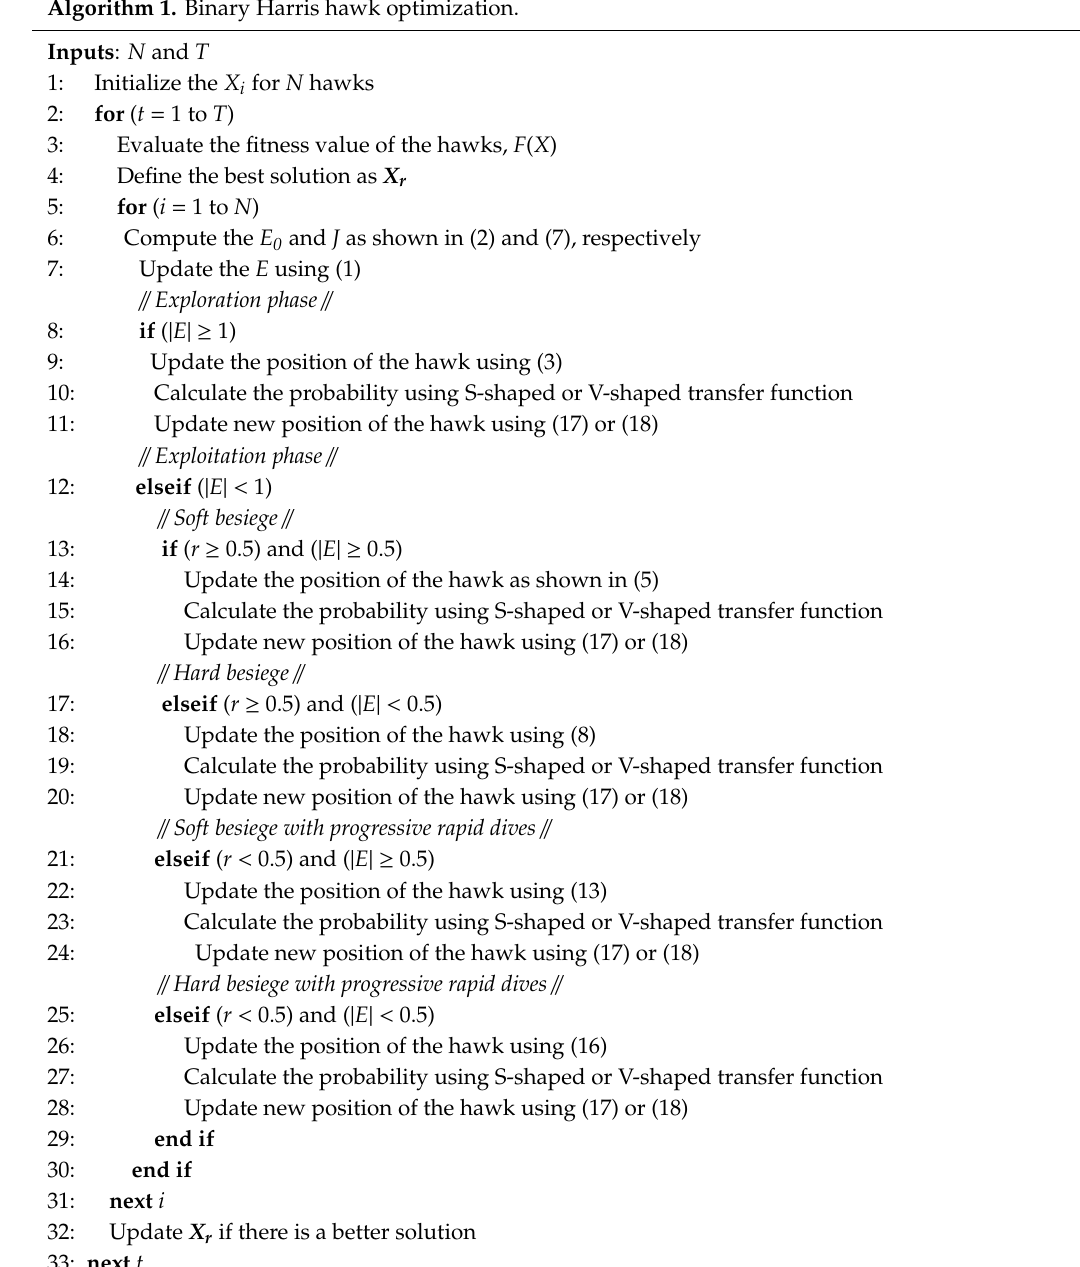
Algorithm 1. Binary Harris hawk